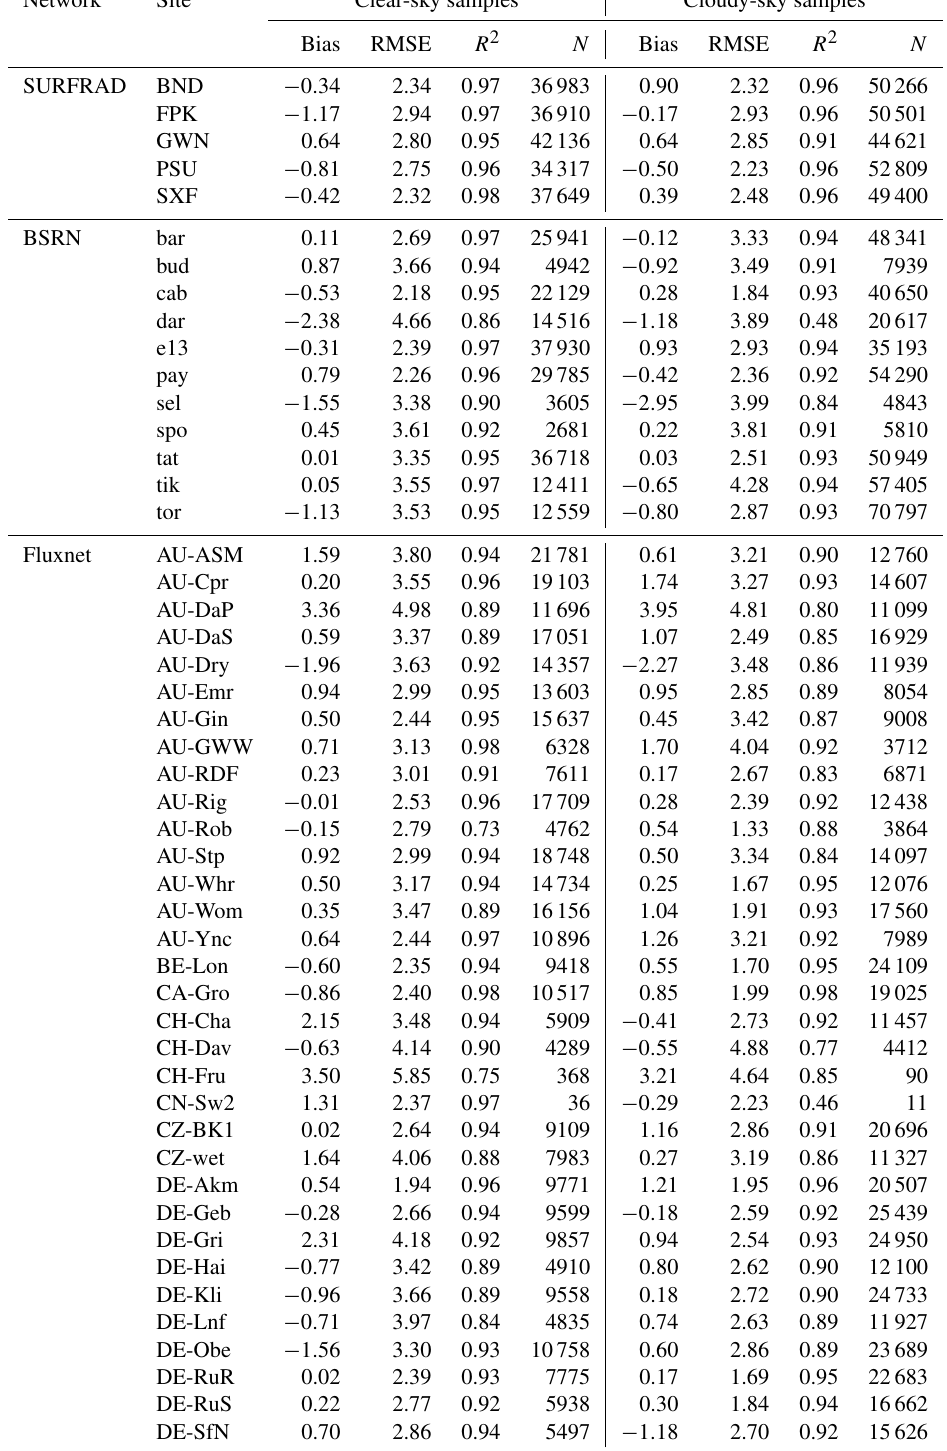
Table A1. Validation statistics of each